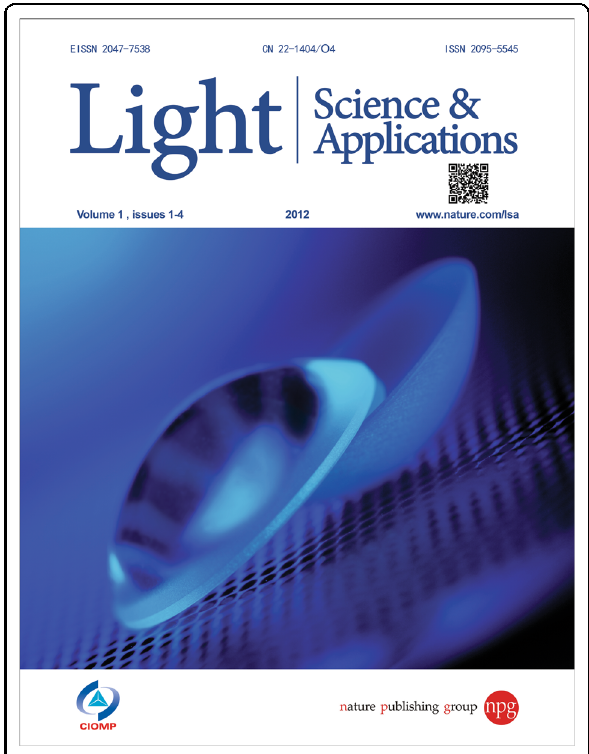
Fig. 5 Inaugural Issue of LSA